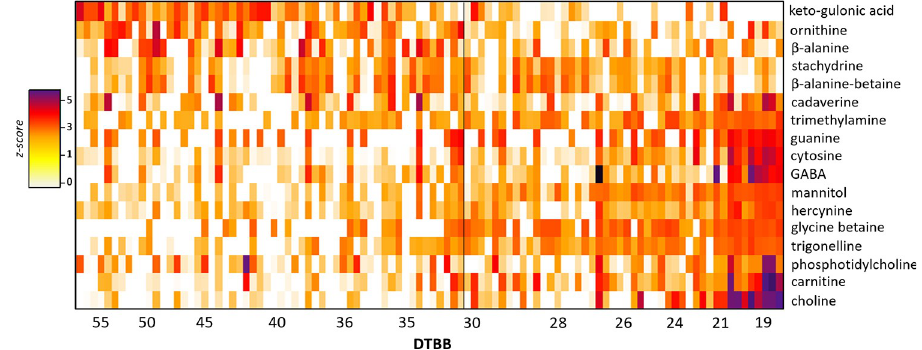
Fig 8. Heat map showing select differentially expressed compounds across the 2019 production season, measured by HILIC, high resolution MS. Peak areas were log transformed, and the compounds were normalised individually. Betaines were a major class of compounds that increased in late season